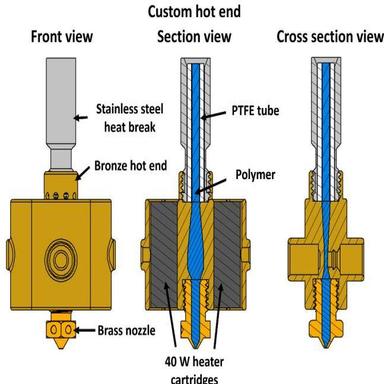
The custom hot end used in the measurement system.